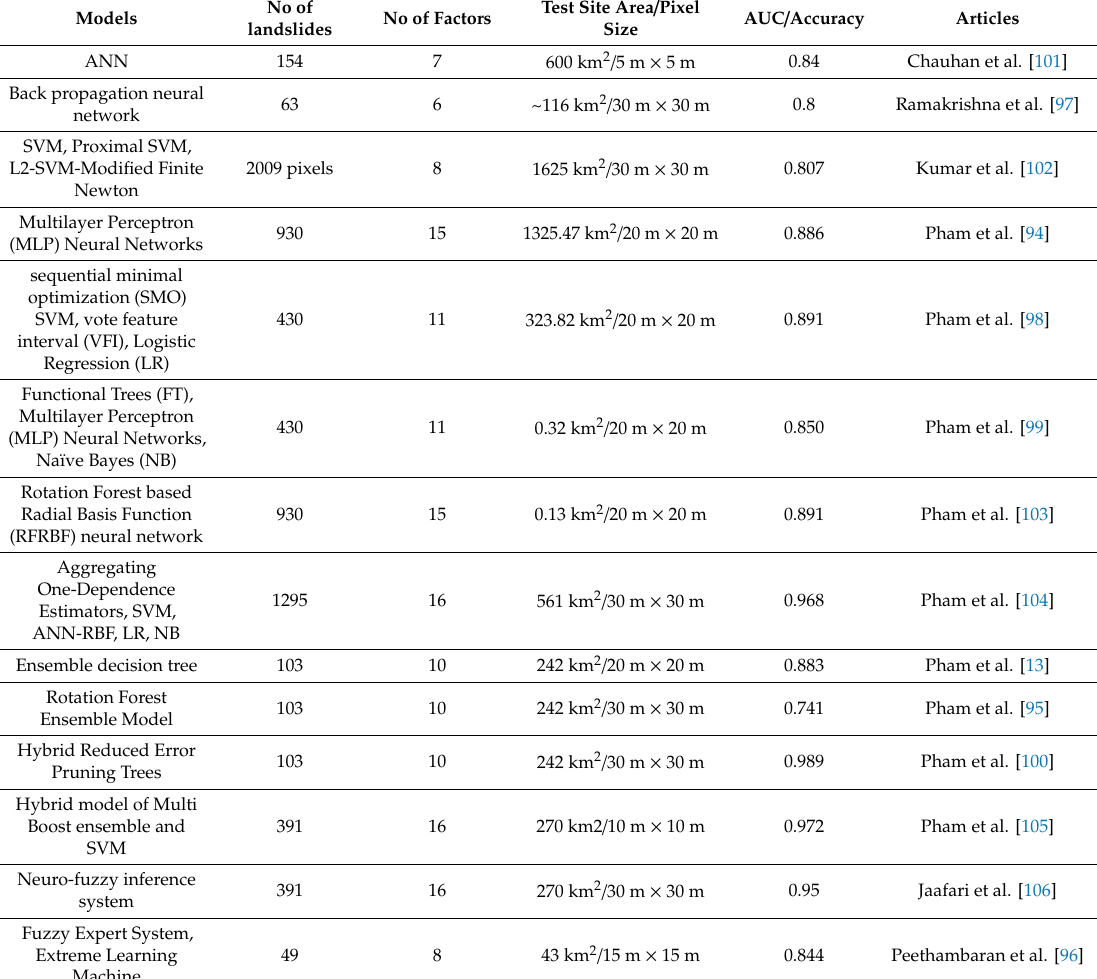
Table 2. Various computational models used for landslide susceptibility in Uttarakhand